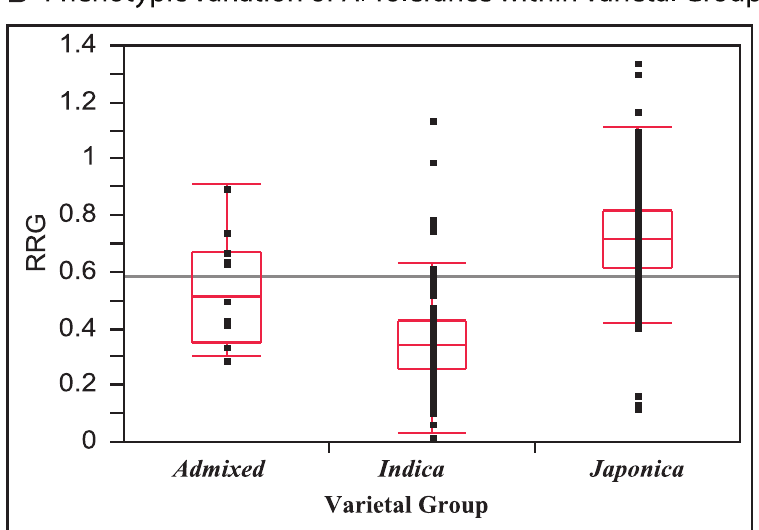
Figure 1. Distribution of Al Tolerance in Rice Diversity Panel. A) Distribution of Al tolerance across 383 diverse accessions of O. sativa at 160 m M Al 3 + . Aluminum tolerance (TRG-RRG) was normally distributed around a mean of 0.59 + / 2 0.24(SD) and ranged from 0.03–1.35. The Al tolerance of the QTL mapping parents are indicated: K=Kasalath, IR=IR64, N=Nipponbare, A=Azucena. B) Variation of Al tolerance (RRG) within genetic varietal groups ( . 80% ancestry). Admixed accessions share , 80% ancestry with either group. The Japonica varietal group ( temperate and tropical japonica and aromatic subpopulations) is significantly more tolerant than the Indica varietal group ( indica and aus subpopulations) (p , 0.0001). Five Indica accessions were identified to be highly Al tolerant outliers and six Japonica outlier accessions were identified, three as highly Al susceptible and three as highly tolerant.